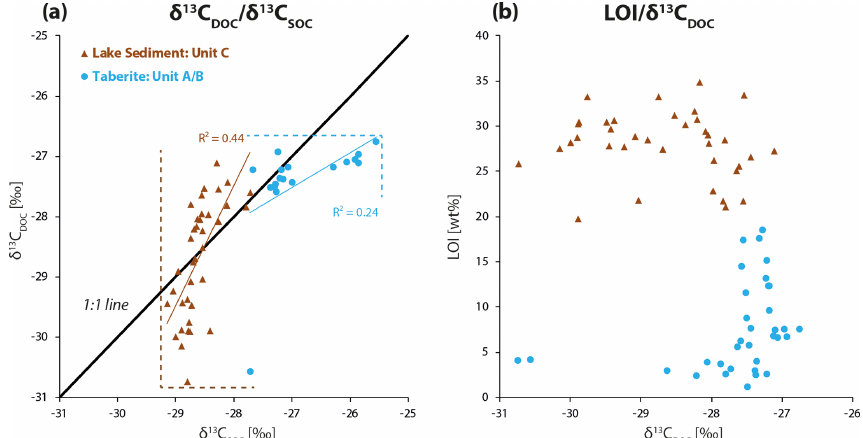
Figure 6. (a) The lake sediment δ 13 C SOC value range is narrow while its δ 13 C DOC value range is wide; the opposite trend is the case for the taberite. The dashed lines highlight the respective δ 13 C DOC and δ 13 C SOC value ranges. The 1:1 line visualizes the changes in values from δ 13 C SOC to δ 13 C DOC in both facies. (b) The loss-on-ignition (LOI) data of the lake sediment are stable at a high level across both lakes and all cores while coinciding with a high variability in δ 13 C DOC values. Conversely, the δ 13 C DOC values of the taberite stay in a narrower range independent of the variability in LOI values. LOI is here used as an equivalent for